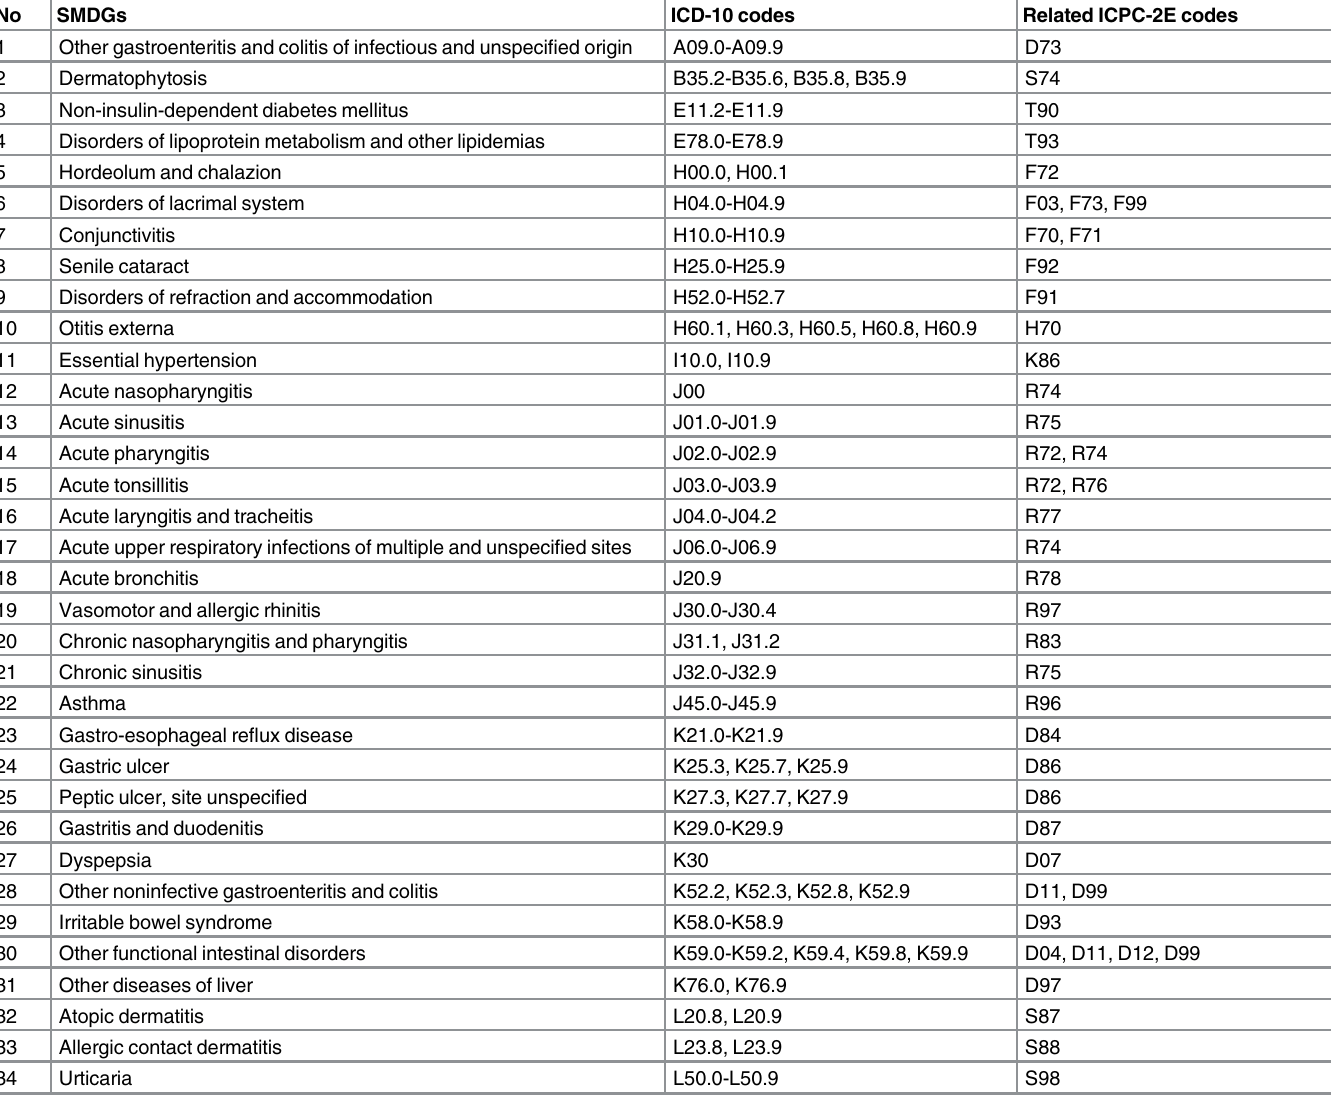
Table 1. ICD-10 codes of SMDGs and related ICPC-2E